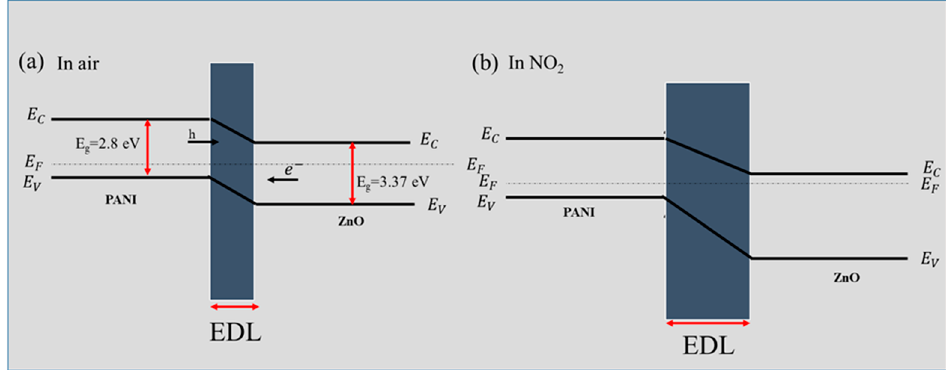
Figure 15. Formation of ZnO ‐ PANI heterojunctions in ( a ) air and ( b ) in the presence of NO 2 gas.